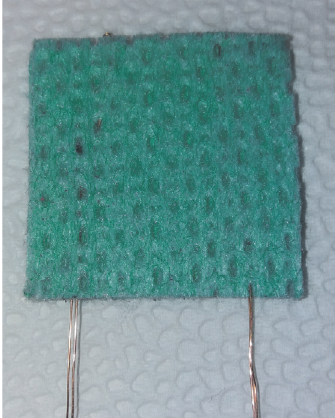
Figure 1: Absorbent microfiber cloth with thickness 0.45 mm.